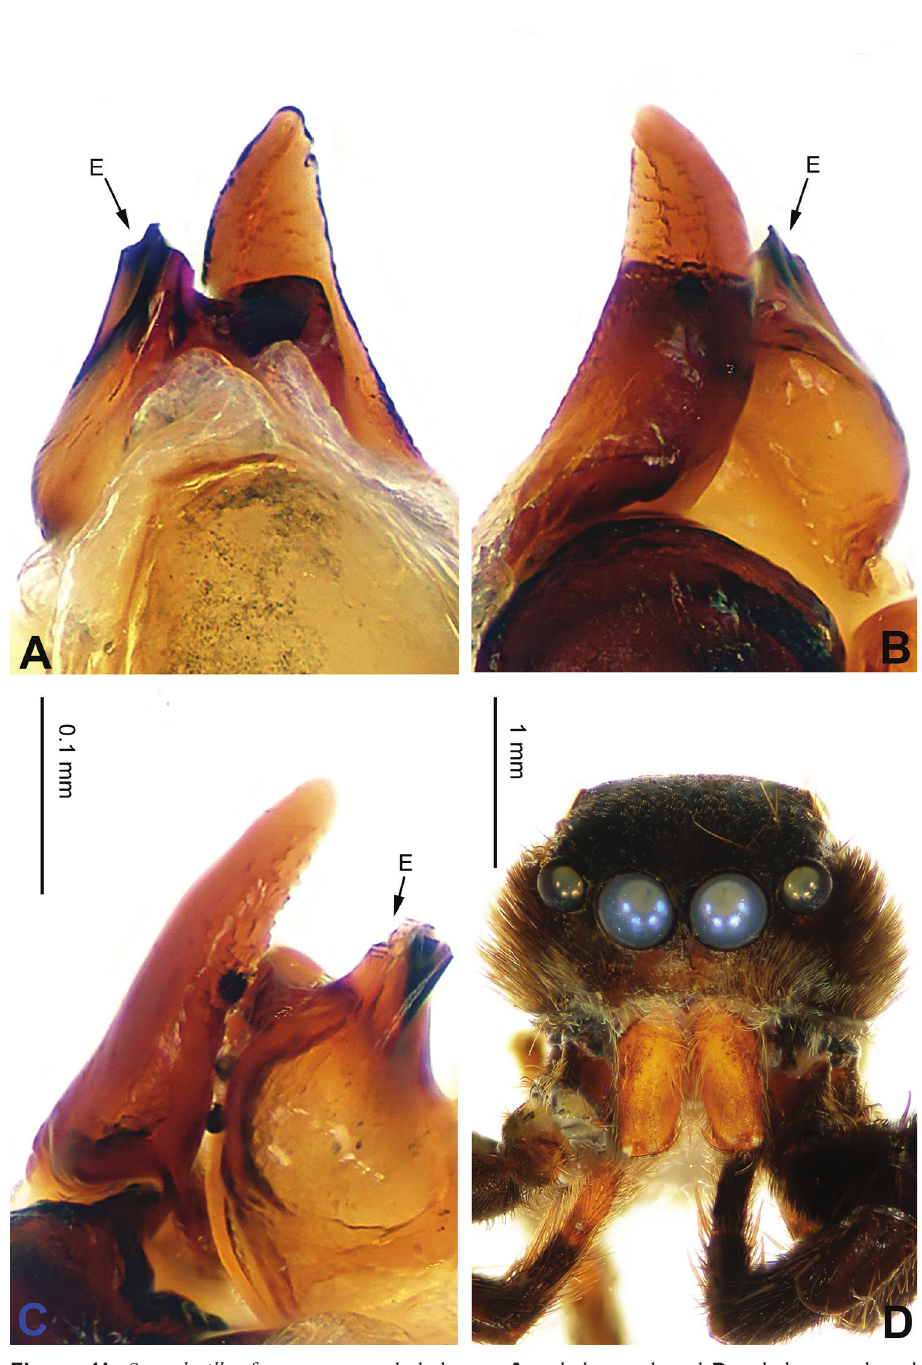
Figure 41. Stenaelurillus fuscus sp. n., male holotype. A embolus, prolateral B embolus, retrolateral C embolus, dorsal D habitus, front. Scale bars equal for A–C